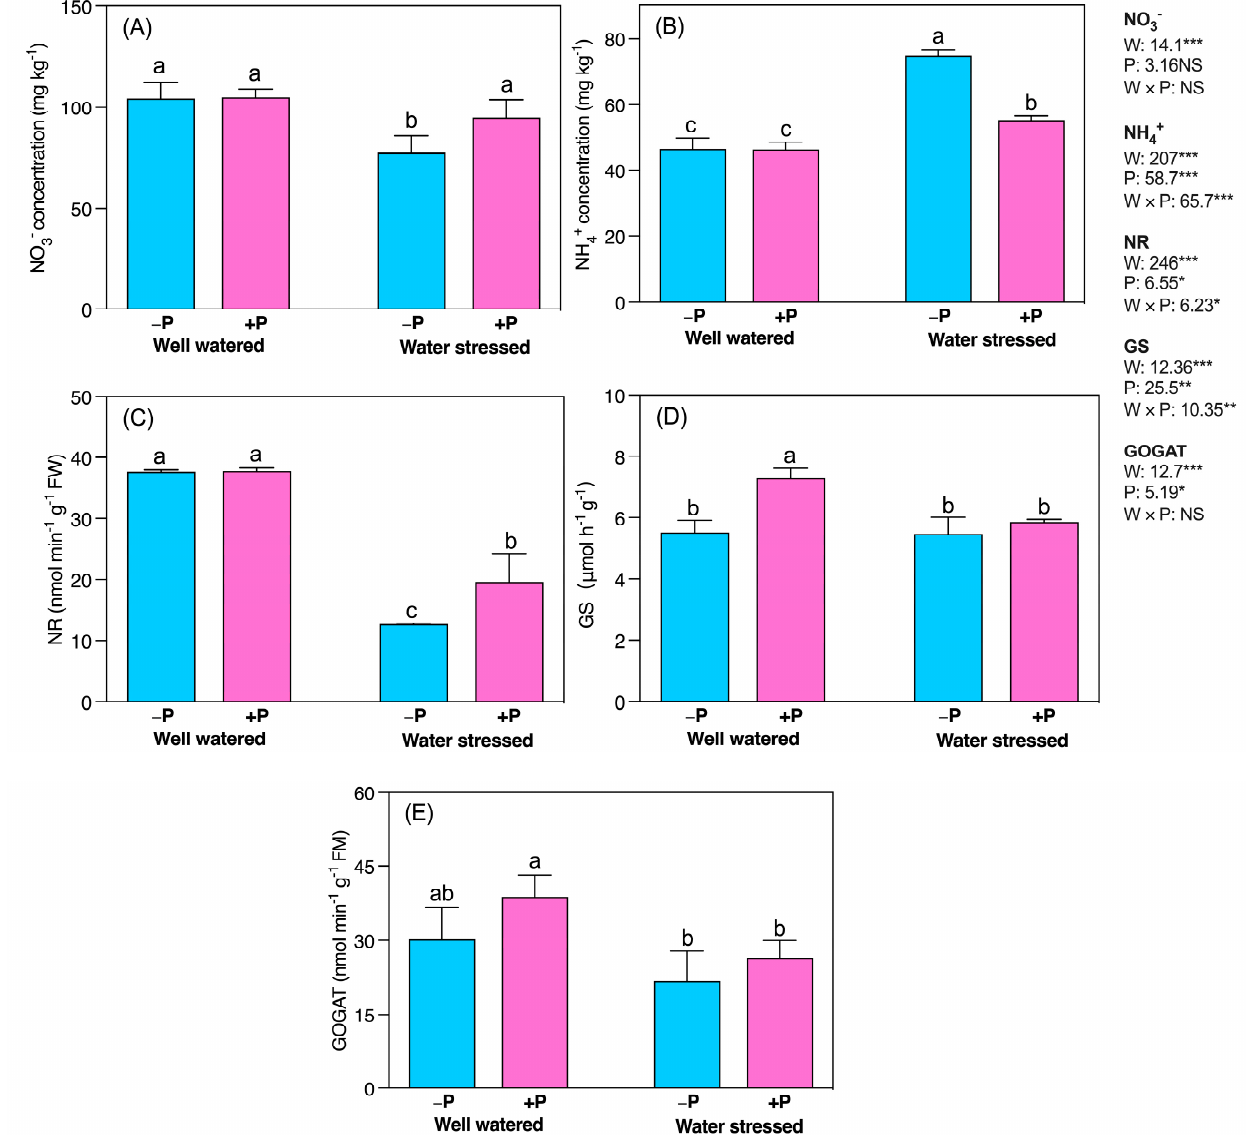
Figure 7. Changes in concentrations of ( A ) NO 3 − and ( B ) NH 4+ , and enzymatic activity of ( C ) NR ( D ) GS, and ( E ) GOGAT in response to P supplementation, under well-watered and drought-stressed conditions. A different letter following the means indicates significant differences ( p < 0.05) between the four treatments, as determined by Duncan’s test. Bars represent means ± SD. An overview of the two-way ANOVA assessing the effect of water (W) and phosphorus (P) treatments is presented in the right-hand corner of each panel. *, ** and *** indicate that F values were significant at p ≤ 0.05, 0.01, and 0.001, respectively.